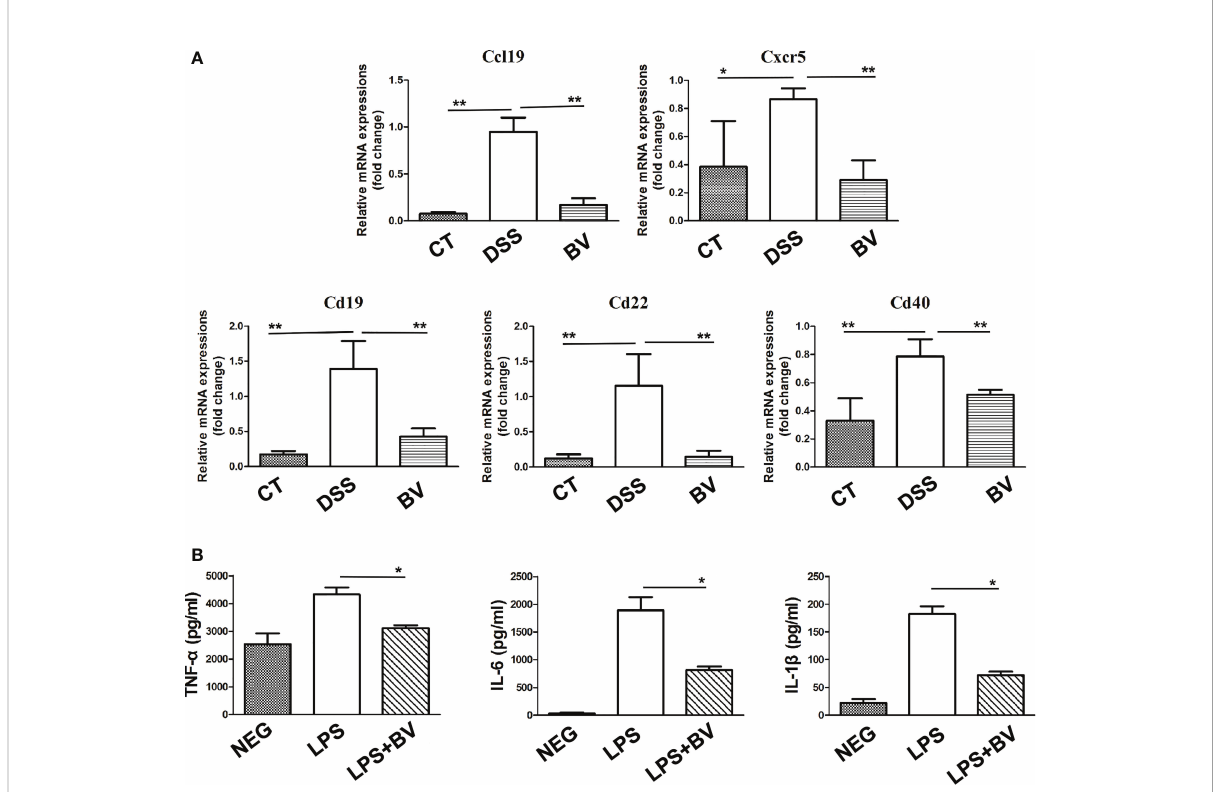
FIGURE 5 Effect of B. vulgatus Bv46 on the expression of Ccl19, Cd19, Cd22, Cd40 and Cxcr5 genes in mice colon and the secretion of TNF- a , IL-1 b and IL-6 in macrophages stimulated by LPS in vitro. CT, DSS, and BV denote control (no DSS induction), DSS induction and treatment with phosphate buffer saline only, and DSS induction and treatment with B. vulgatus Bv46 respectively. (A) Effects of B. vulgatus Bv46 administration on the expression of in fl ammatory genes in DSS-induced colitis mice. Mouse colons were collected and the mRNA expression of Ccl19 , Cxcr5 , Cd19, Cd22 , Cd40 was quanti fi ed using real-time PCR. Fold changes are expressed as mean ± SD ( n = 3 each group). *P < 0.05, **P < 0.01. (B) The cytokine pro fi les (concentrations of TNF- a , IL-1 b and IL-6) of the supernatants after the cultivation of untreated RAW264.7 cells or cells after treatment with LPS or LPS+BV. Error bars are SD. *P < 0.05 for LPS+BV versus LPS. NEG, negative